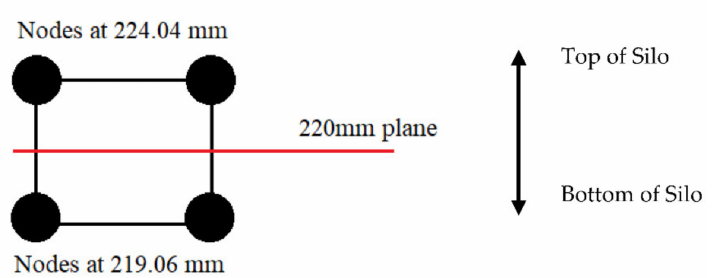
Figure 17. Node locations considered for the 220 mm plane; side elevation